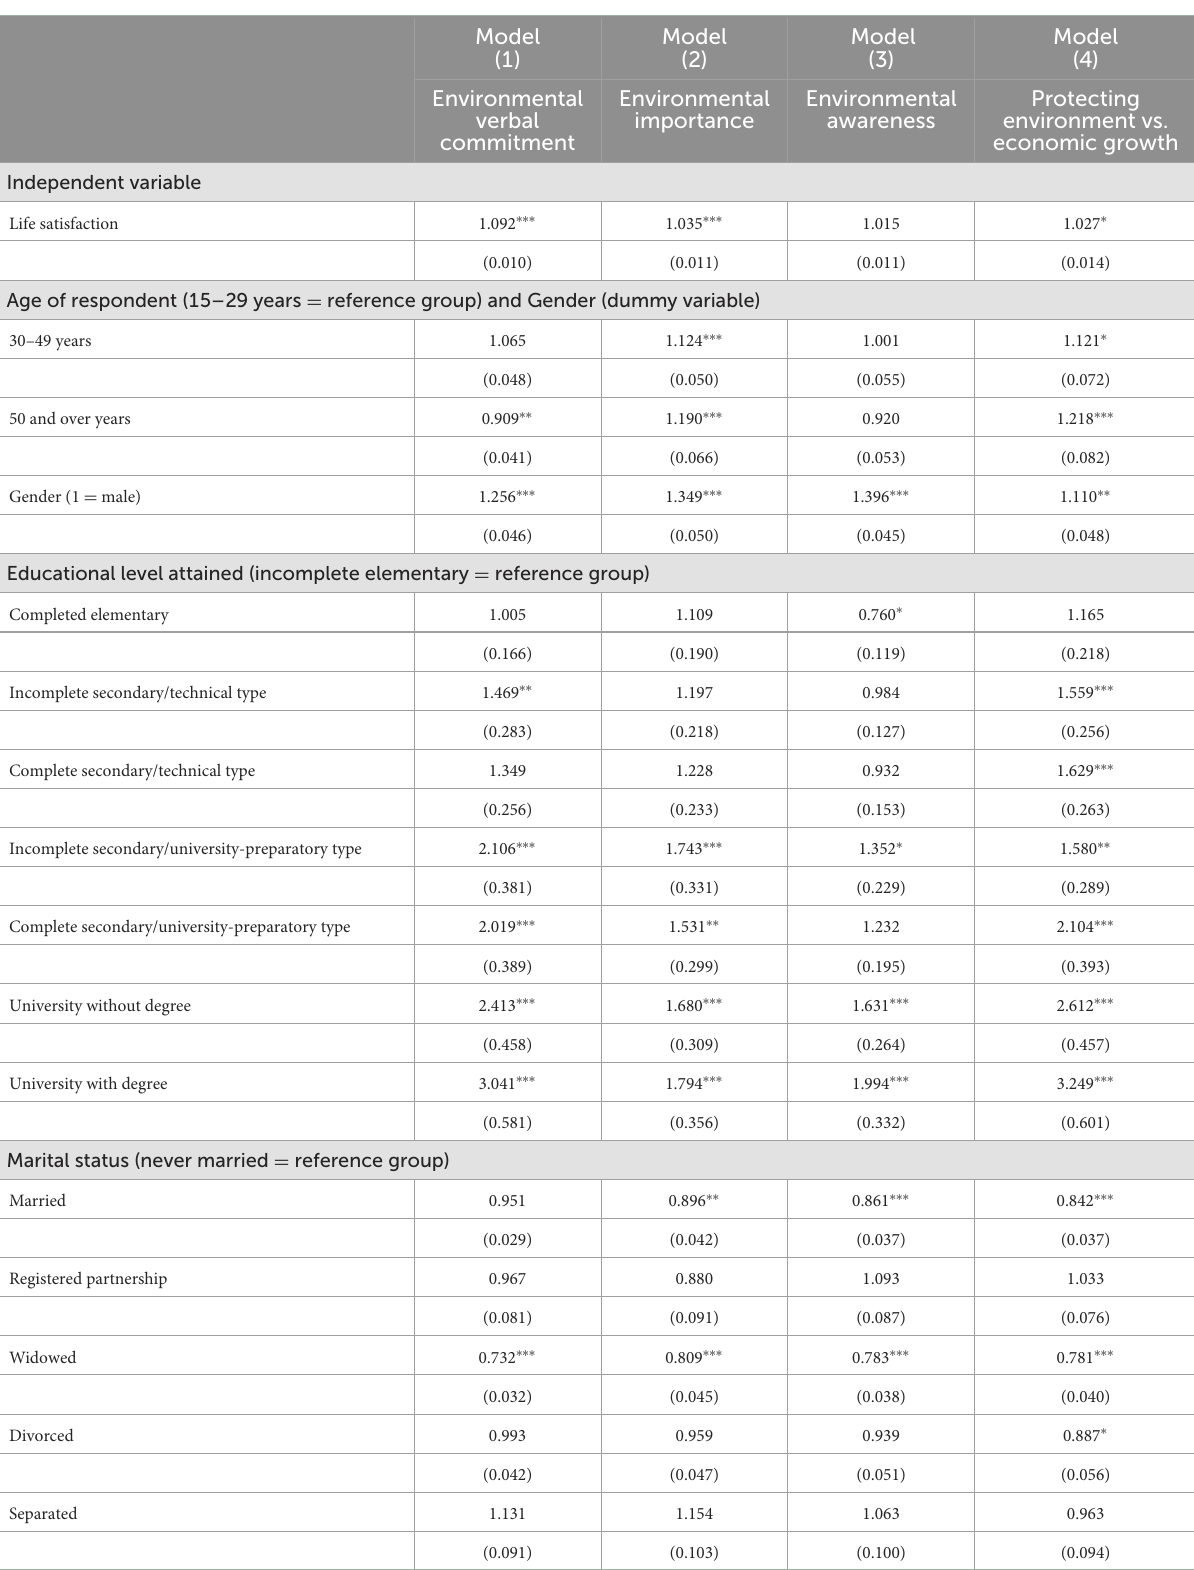
TABLE 2 Log-odds estimations with additional control